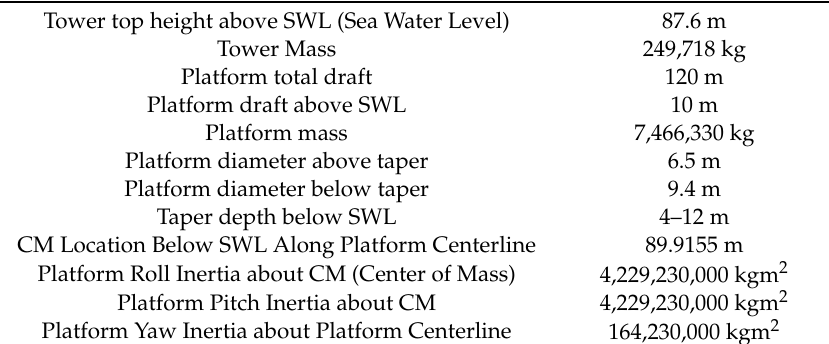
Table 1. OC3-Hywind concept specifications [6].